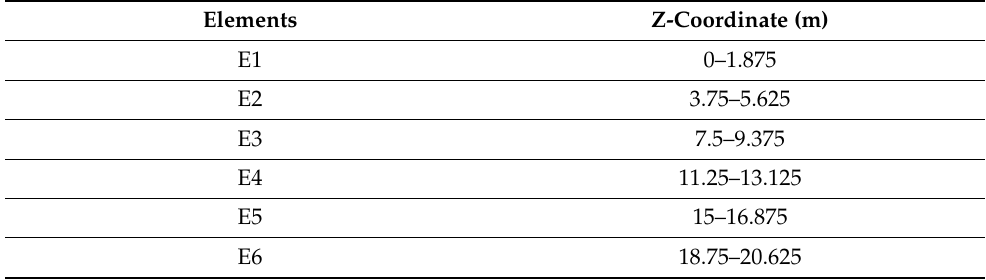
Table 7. Table summary of maximum equivalent stress of the storage tank under blast loadings. Blast Intensity of TNT Equivalent